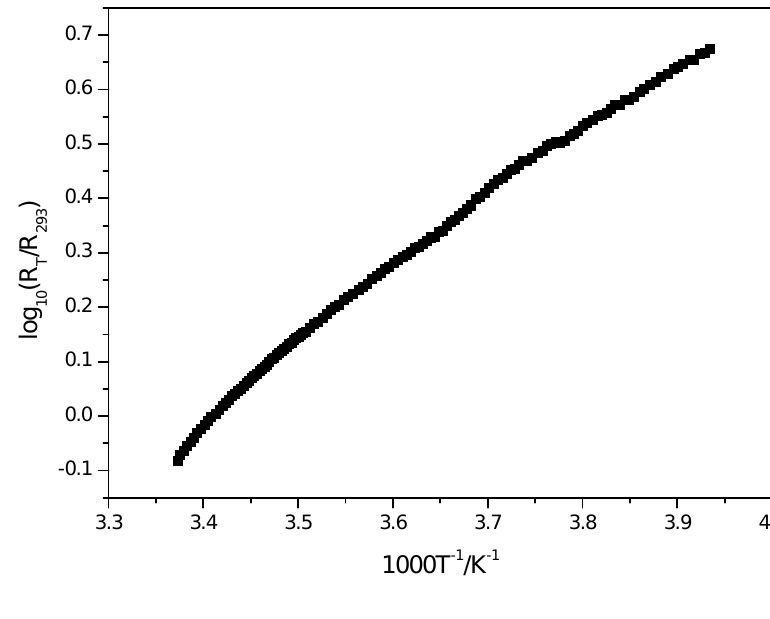
Figure 8. Temperature dependence of resistance for polycrystalline of